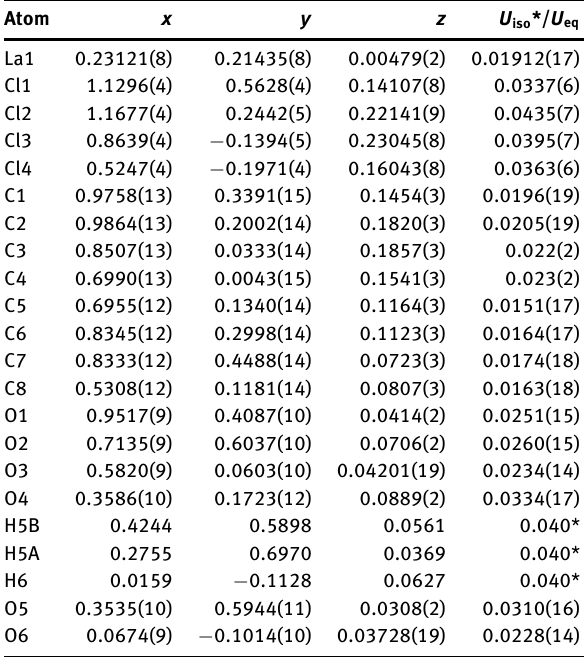
Table 2: Fractional atomic coordinates and isotropic or equivalent isotropic displacement parameters (Å 2